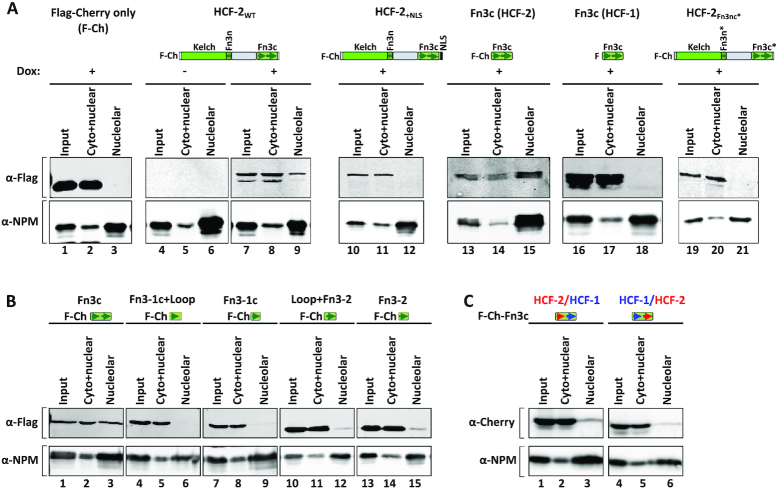
Fn3c facilitates HCF-2 but not HCF-1 nucleolar localization. (A) F-Cherry-only (F-Ch), F-Cherry-HCF-2WT, F-Cherry-HCF-2+NLS, F-Cherry-HCF-2Fn3c, F-HCF-1Fn3c or F-Cherry-HCF-2Fn3nc* (see respective protein structure models on top) synthesis in HEK-293 T-REx cells was induced with doxycycline (1 μM for 24 h) and samples were subjected to nucleolar fractionation. Induction of recombinant protein synthesis is shown for F-Cherry-HCF-2WT (–, without doxycycline; +, with doxycycline). Presence or absence of recombinant HCF proteins was analyzed with α-Flag antibody (upper panels), and the quality of nucleolar purification assayed with the α-NPM antibody (lower panels). (B) Both Fn3c type repeats facilitate nucleolar localization of HCF-2. HEK-293 cells were transiently transfected with plasmids encoding F-Cherry-HCF-2Fn3c truncations and 24 h later collected for nucleolar fractionation. Presence or absence of recombinant F-Cherry-HCF-2Fn3nc truncations was analyzed with α-Flag antibody (upper panels), and the quality of nucleolar purification assayed with the α-NPM antibody (lower panels). (C) As in (B), but with plasmids encoding hybrid HCF-1 and HCF-2 F-Cherry-Fn3c sequences. HCF-2/HCF-1, Fn3–1cHCF-2/Fn3–2HCF-1 hybrid; HCF-1/HCF-2, Fn3–1cHCF-1/Fn3–2HCF-2.